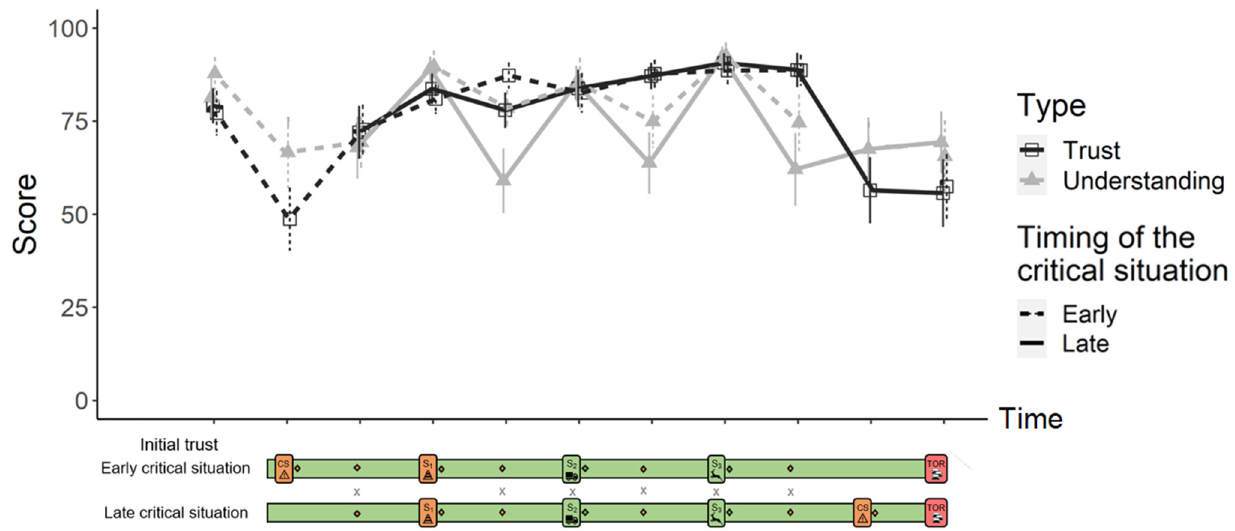
Figure 5. Trust and understanding scores for drivers who were assigned to the inconsistent feedback condition. Grey crosses indicate the moment of feedback inconsistencies (error bars: standard error). Table 4. Linear models of trust and perceived understanding. ***: p < 0.001; **: p < 0.01; *: p < 0.05; ns: not